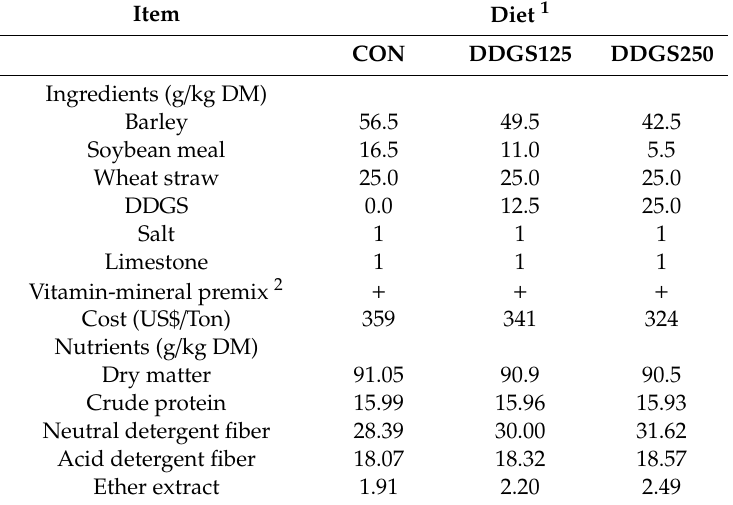
Table 1. Ingredients and chemical composition of diets fed to growing Awassi lambs containing increasing concentrations of dried distillers’ grains with solubles (DDGS), replacing barley grain, soybean meal, and wheat straw. Item Diet 1 CON DDGS125 DDGS250 Ingredients (g / kg DM) Barley 56.5 49.5 42.5 Soybean meal 16.5 11.0 Wheat straw 25.0 25.0 DDGS 0.0 Limestone Vitamin-mineral premix 2 Cost (US$ / Ton) 359 324 Nutrients (g / kg DM) Dry matter Crude